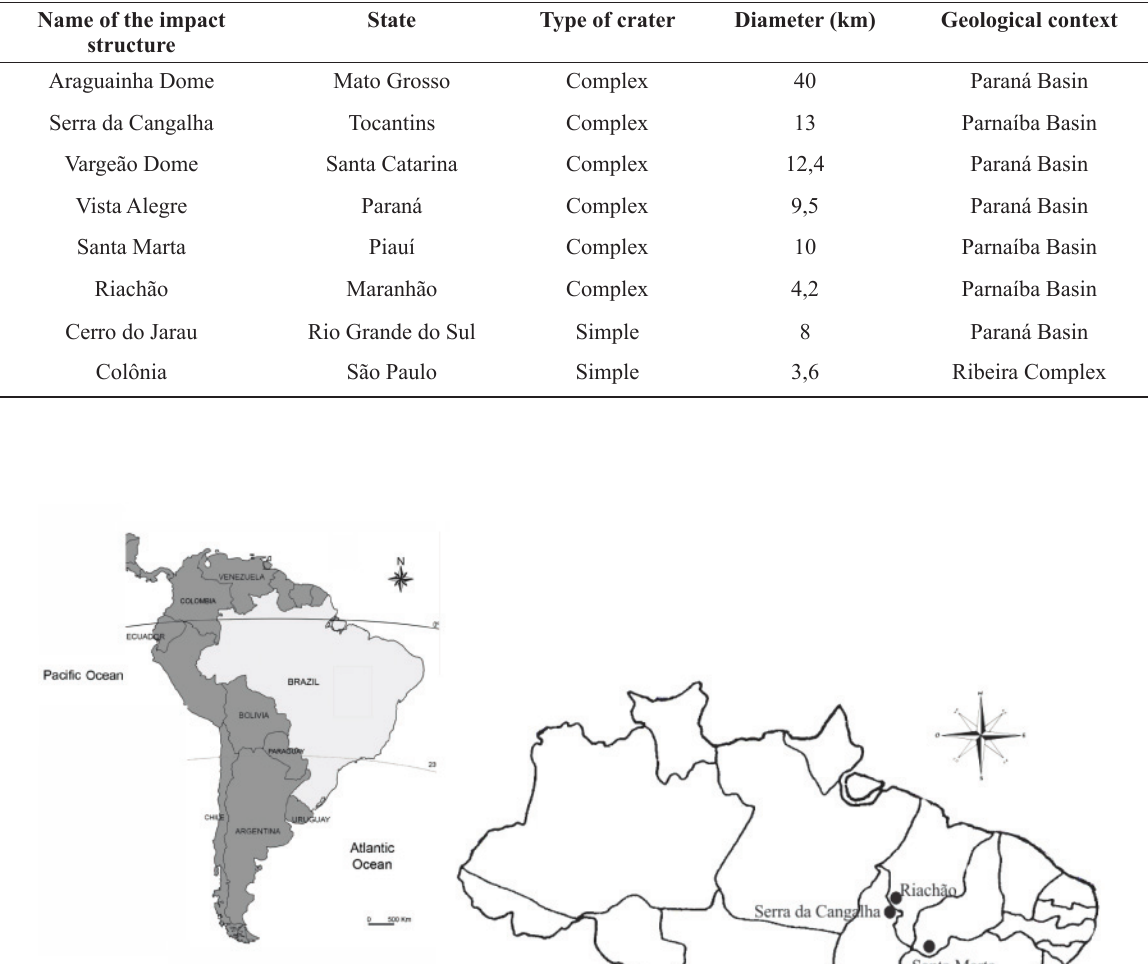
main characteristics of impact structures occurring in Brazil.